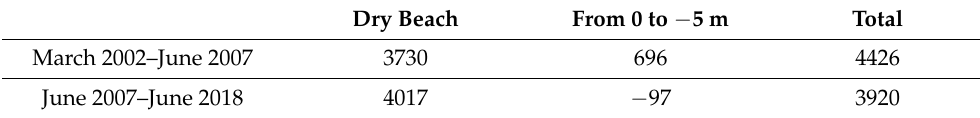
Table 3. Beach volumetric changes during the studied period (m 3